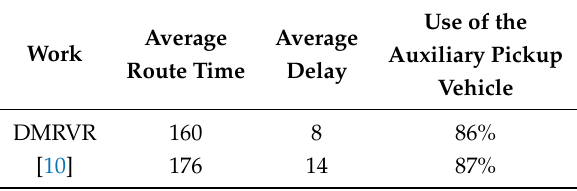
Table 8. Dynamic vehicle routing